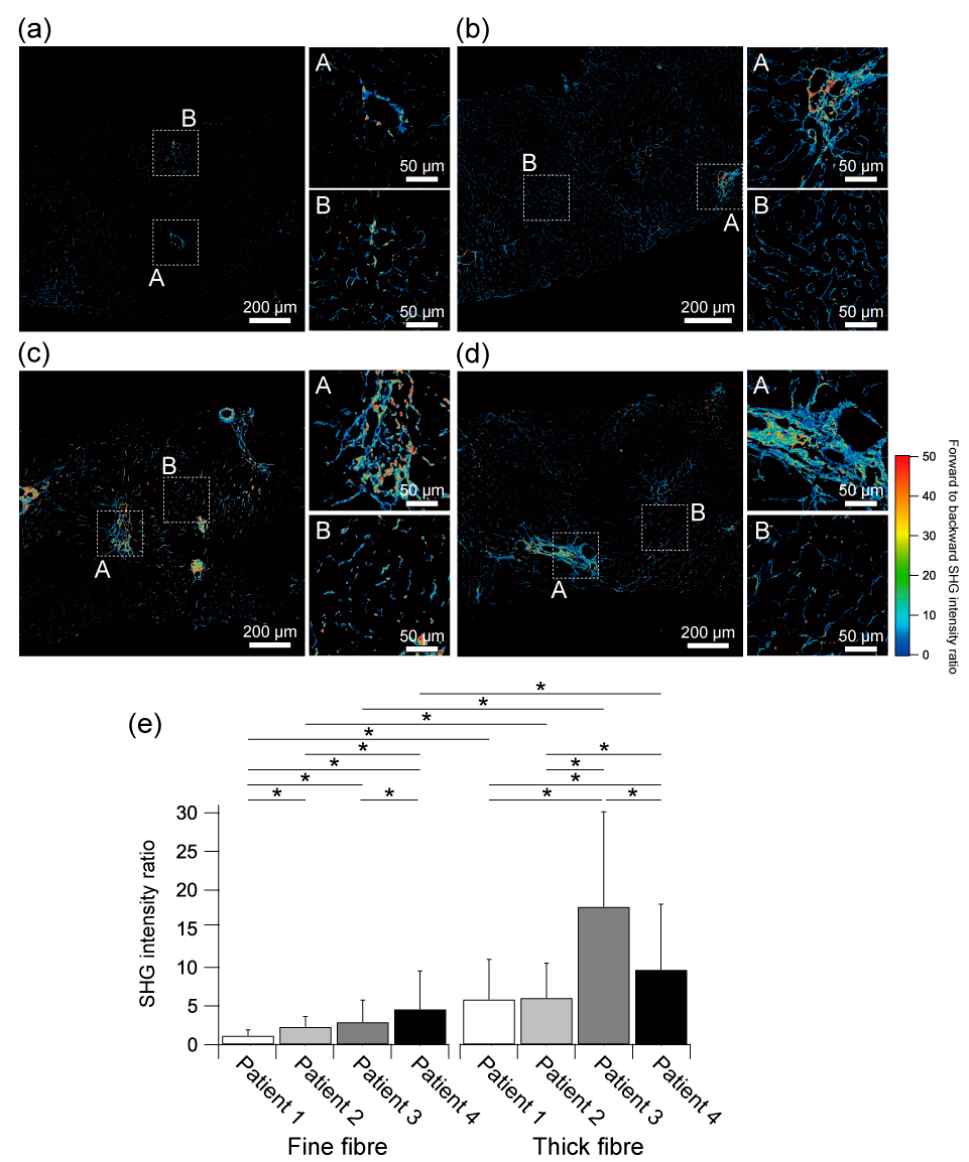
Figure 4. Molecular maturation assessment of collagenous fibre by SHG directionality analysis. SHG intensity ratio images of the livers of ( a ) ultra-early stage of NAFLD (Patient 1), ( b ) ultra-early stage of NAFLD (Patient 2), ( c ) early stage of NASH (Patient 3), and ( d ) advanced stage of NASH (Patient 4). ( e ) Mean SHG intensity ratio of fine (less than 2 μ m) and thick (2 μ m or thicker) fibrous tissues at each patient. N.A., not applicable. Asterisks indicate a statistically significant difference (* p < 0.01). Error bar, standard deviation.